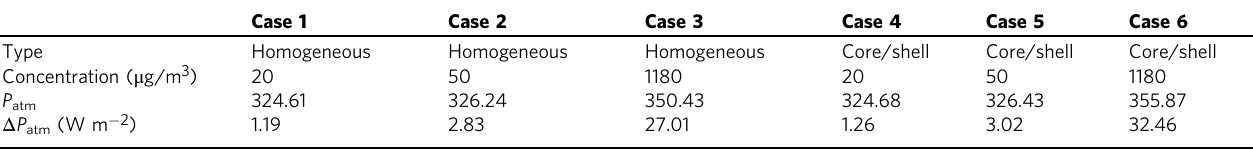
Table 1 The changes in the thermal radiation power density by different